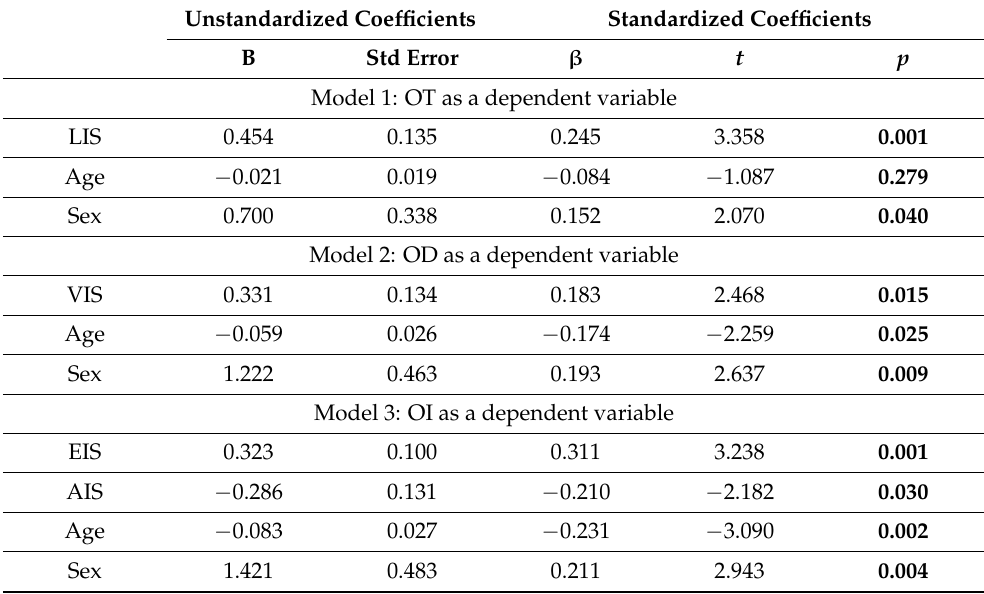
Table 4. Multiple linear regression analysis models using odor discrimination (OD), odor identifi- cation (OI), odor threshold (OT), TDI score as dependent variables and each significant correlated factor of MoCA sub-scores, age, and sex as independent